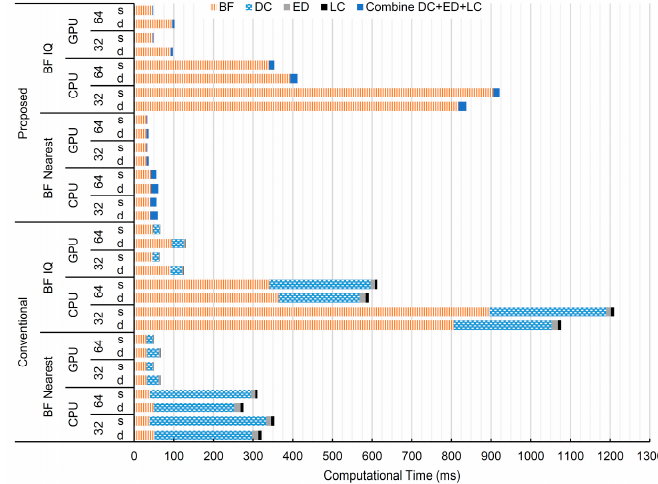
Figure 10. The mean of the computational time for ultrasound image reconstruction using different combinations of the following: the conventional and the purposed methods, the beamforming using the nearest sample and that using I/Q interpolation methods, the 32-bit and the 64-bit computer platforms and the double (D) and the single (S) precision FP formats. Notes: BF = beamforming, DC = DC cancellation, ED = envelope detection and LC = log compression.